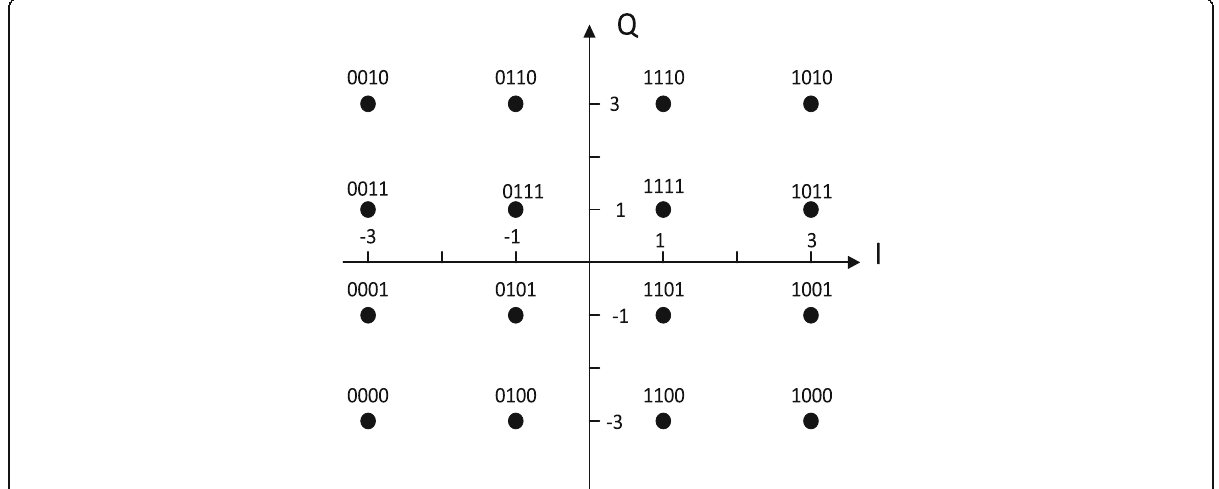
Fig. 14 The constellation of the 16QAM modulation. The I -way component and Q -way component correspond to b 0 b 1 and b 2 b 3 in the code elements b